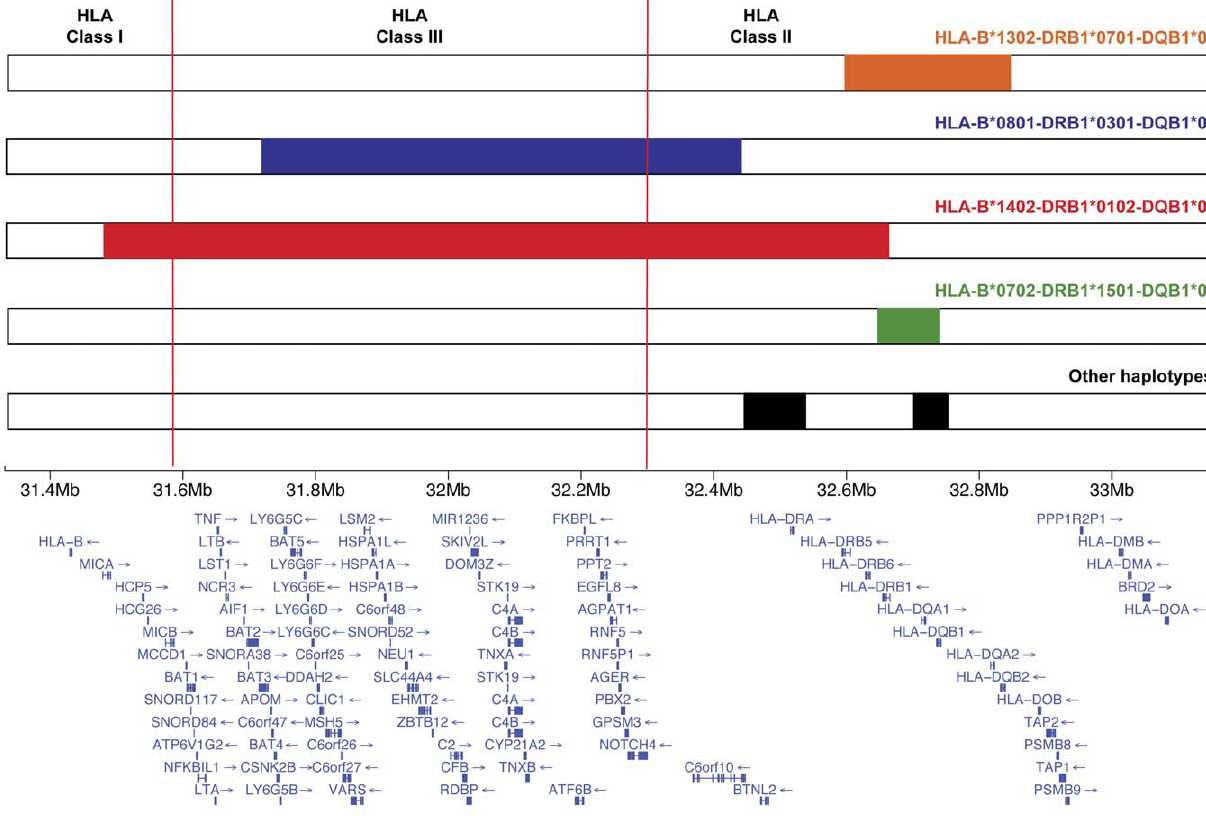
Figure 4. Summary of most significant independent association signals in the HLA locus. For each conserved haplotype background the critical region where the putative causal variant is more likely to be located is highlighted. Genomic positions on the x-axis are based on the NCBI Build 36 (hg 18) assembly. Mb, megabase pairs.